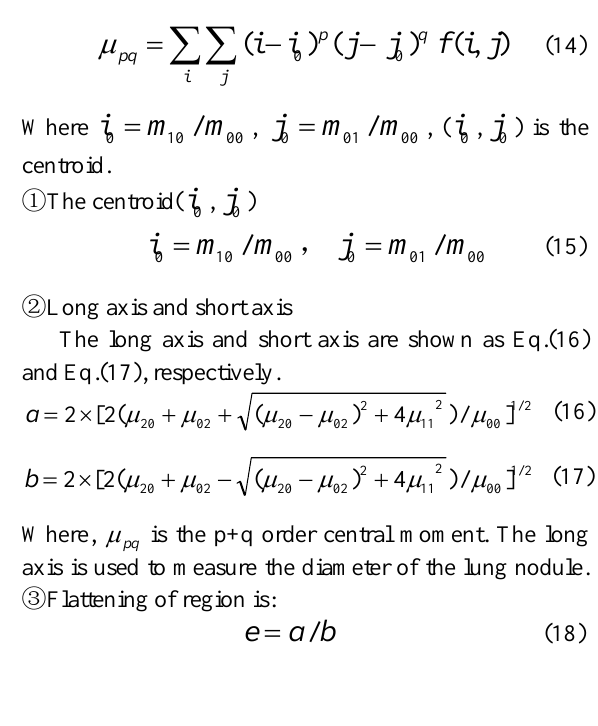
Fig. 9. Result of the suspected solitary lung nodules segmentation. (a)original image, (b)NAD filtering enhancing, (c)the proposed